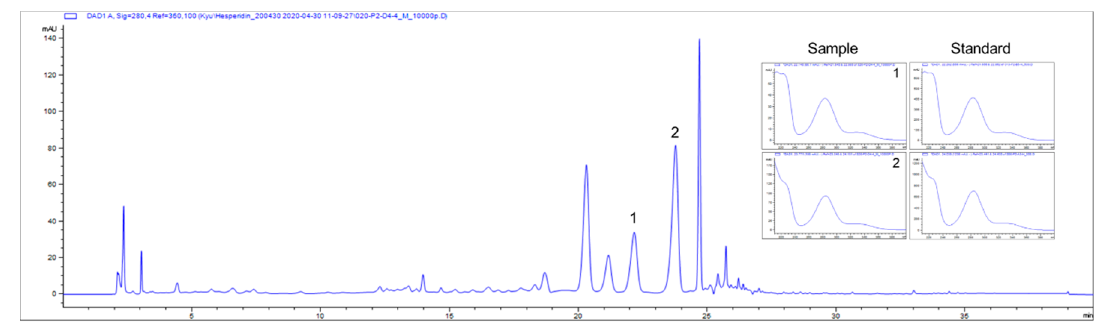
Figure 1. Chemical profile of Citrus junos Tanaka peel extract (CE). Representative HPLC chromatogram of the CE at 280 nm. The arrowed peak has been identified as naringin (1) and hesperidin (2). UV spectra of the standard and 50% ethanolic CE extract.